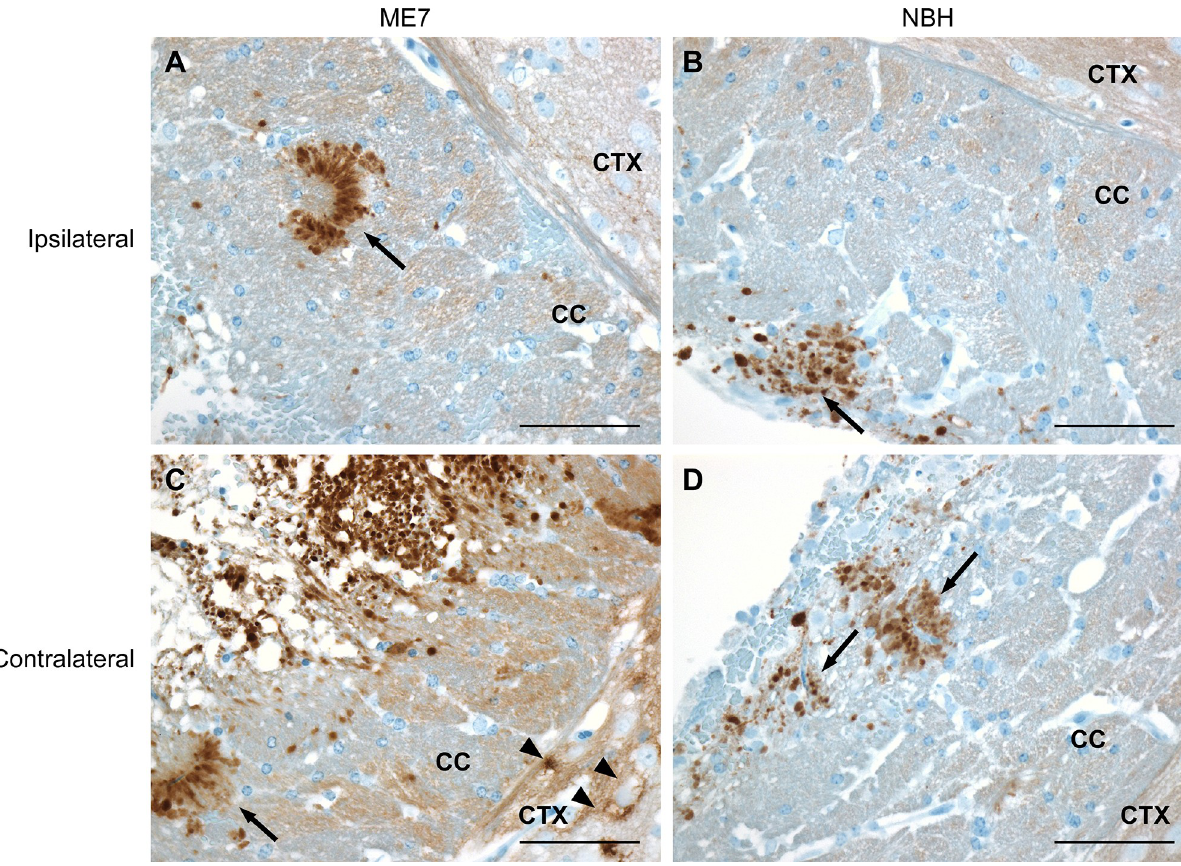
Fig 3. Endogenous PrP-3F4 staining in the corpus callosum and adjacent cortex in Tg3F4 mice following inoculation with ME7 prions or NBH. (A and B) PrP-3F4 staining in the corpus callosum and adjacent cortical tissue on the inoculated side of the brain (Ipsilateral) and (C and D) uninoculated side of the brain (Contralateral) 24 hrs post-inoculation. Arrows indicate PrP-3F4 staining around blood vessels. Arrowheads indicate diffuse PrP-3F4 staining around cells in the cortex distinct from that seen in normal uninoculated Tg3F4 brain (compare to Fig 2A). NBH = normal mouse brain homogenate; CC = corpus callosum; CTX = cortex. Scale bar = 50 μ m.